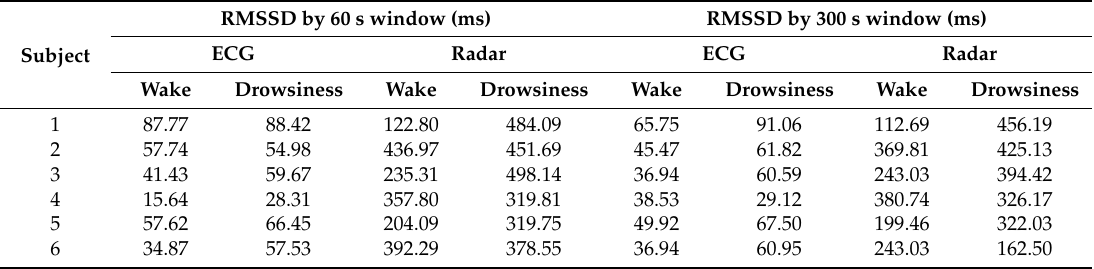
Table 6. The average of RMSSD in the wake–drowsiness state obtained from the analysis